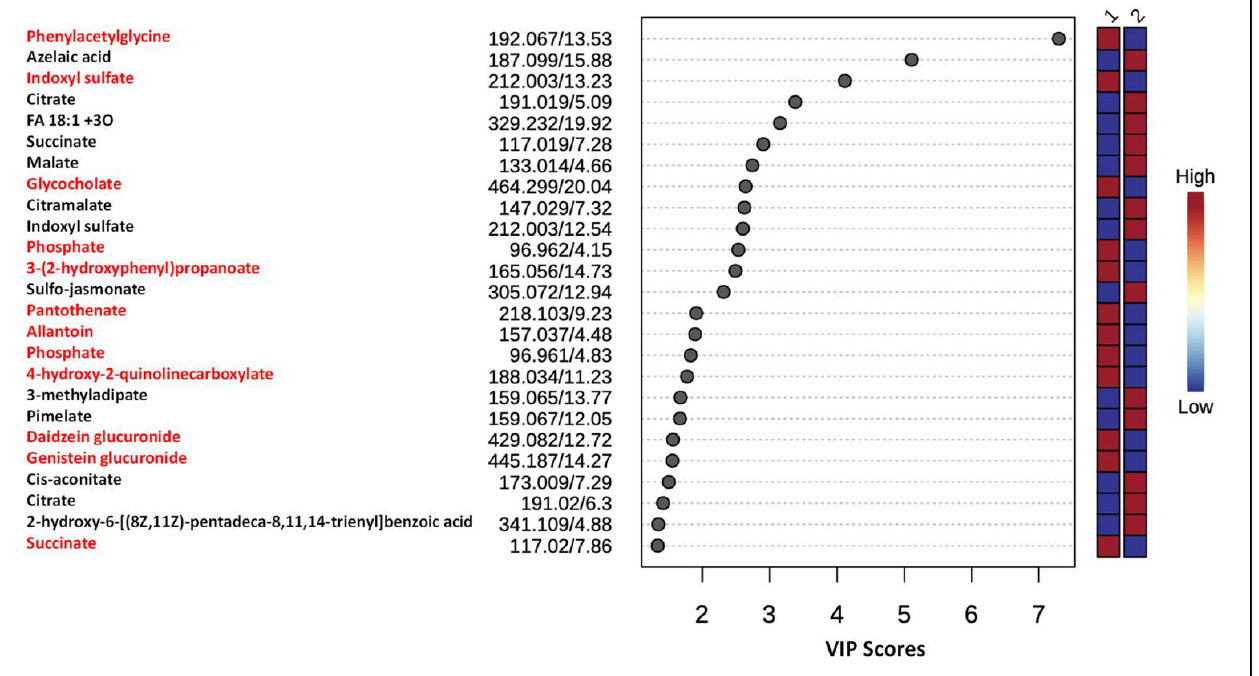
Figure 2. Variable Importance of Projection (VIP) scores for the 25 features most contributing to the PLS-DA plots in the negative ion mode. Colored boxes on the right side indicate the relative intensity of the corresponding feature in each group. ND = not determined. 1 = gID − fed animals, 2 = non − gID-fed animals. Metabolites highlighted in red indicate their higher levels in animals fed with gID.